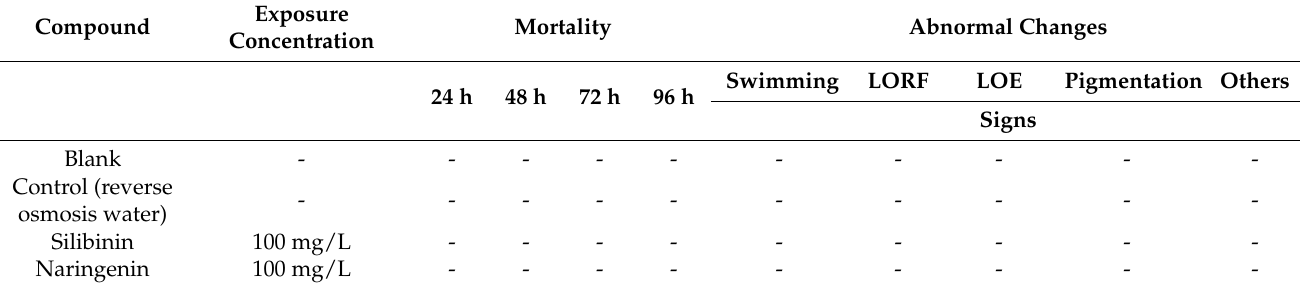
Table 5. Observation of mortality and abnormalities in the acute toxicity test (96